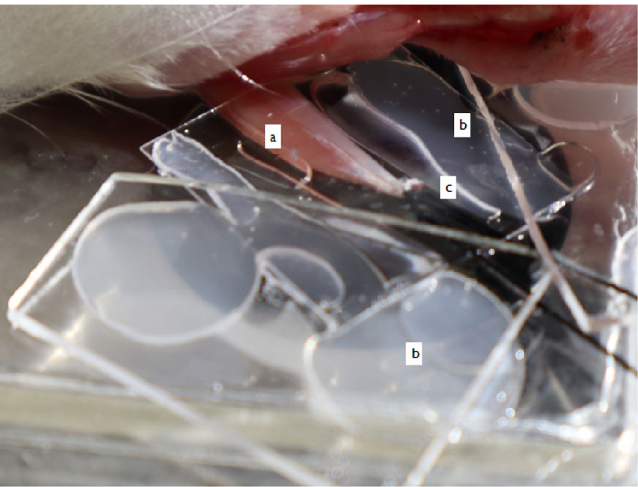
Figure 3. Tissue preparation for IVM. Exteriorized EDL muscle (a) prepared for intravital microscopy. In these observations. The muscle is covered with saran wrap to prevent desiccation and covered with a cover glass slip. Small drops of silicone sealant (b) are used to keep the glass coverslips in place. A suture (c) attached to the muscle–tendon is used to hold the muscle in place and keep the muscle at its approximately in situ lengths (image produced by author B.